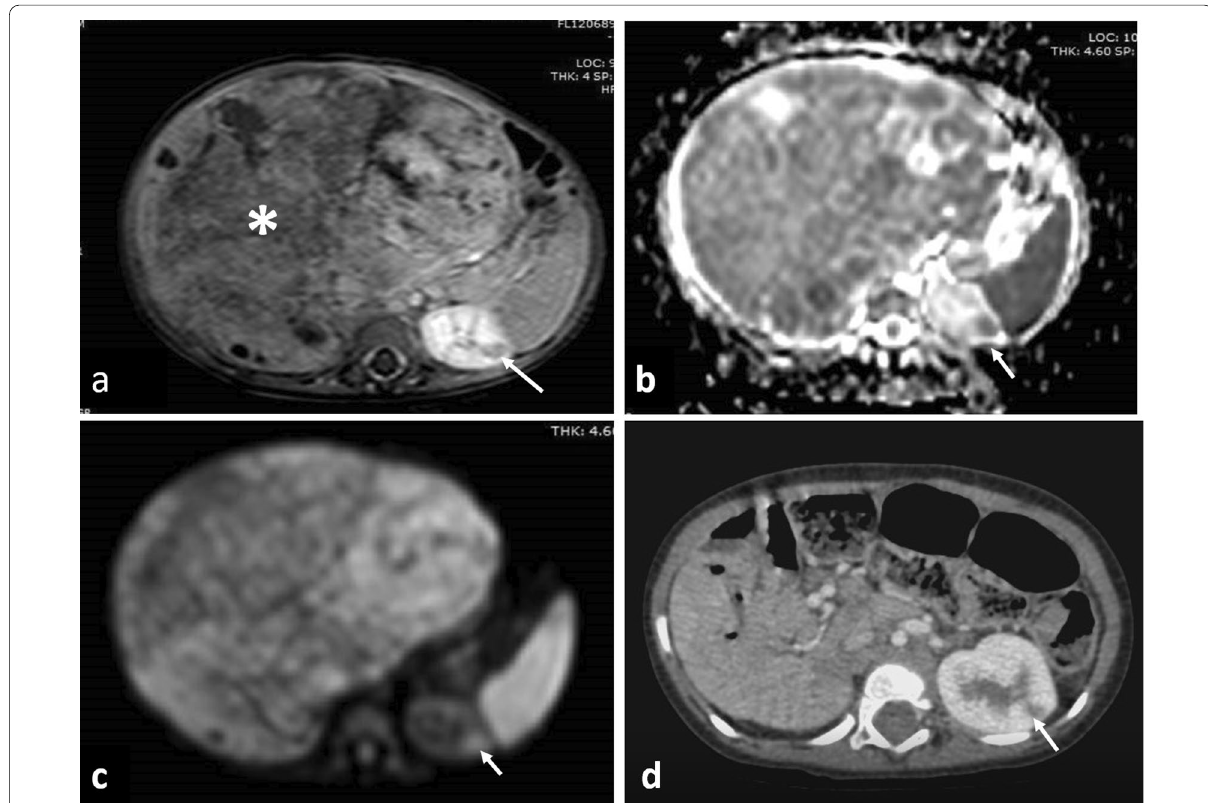
Fig. 11 11-month-old boy with right Wim’s tumor and foci of nephrogenic rests on the left side. a Preoperative post-contrast Fat Sat. T1WI shows a large heterogeneously enhancing renal tumor on the right side (asterisk). The nephrogenic rest on the left side is hypo-enhancing compared to renal tissue (arrow) b , c ADC and DWI, respectively, showing the Wilms tumor (asterisk) and nephrogenic rests (arrow) exhibiting diffusion restriction. d Follow up CT ten months after surgery showing stationary appearance of the nephrogenic rest